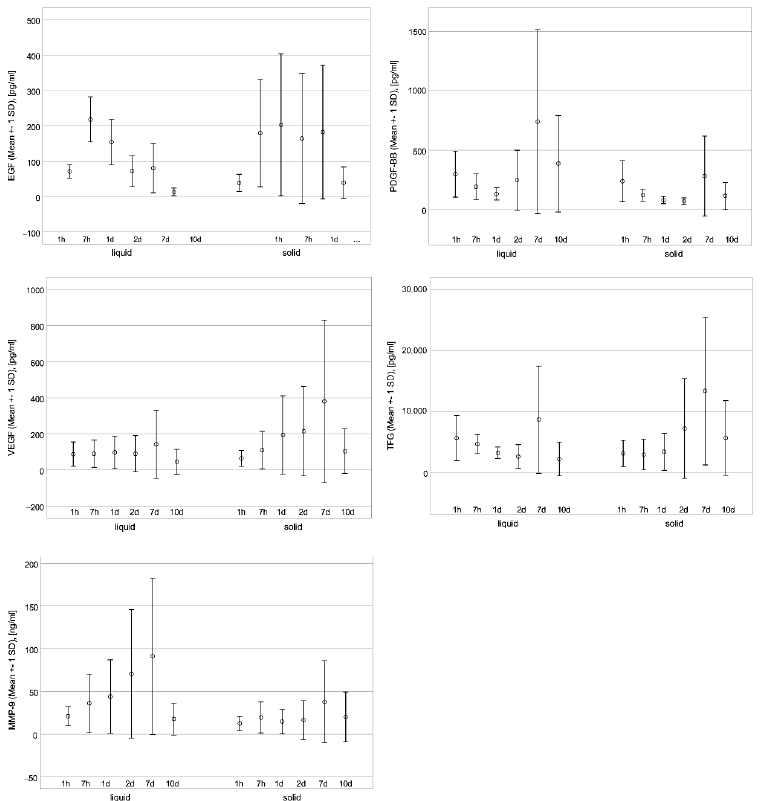
Figure 2. Growth factor release with error bars EGF (pg/mL), VEGF (pg/mL), TGF β -1 (pg/mL), PDGF-BB (pg/mL), and MMP-9 (ng/mL).